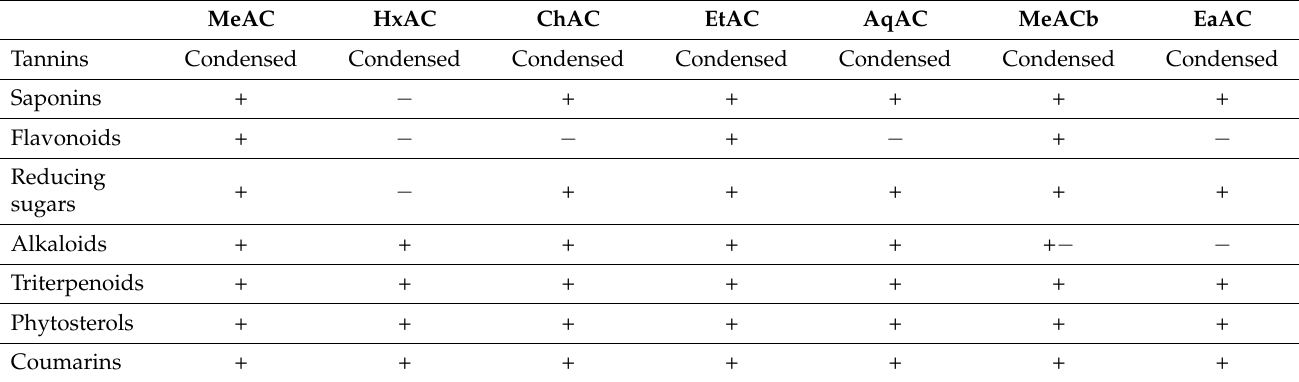
Table 1. Phytochemical